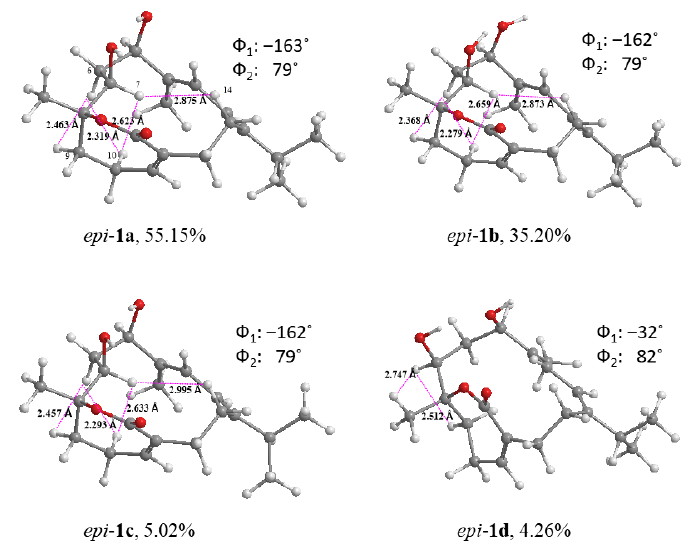
Figure 4. Low-energy conformers, populations, key proton-proton distances, and dihedral angles ( Φ 1 (H7-C7-C6-H6 pro-S ) and Φ 2 (H7-C7-C6-H6 pro-R )) of 7 R* , 8 R* - 1 ( epi - 1 ) at CAM-B3LYP/6-31+G(d,p) IEFPCM (CHCl 3 ) level of theory.